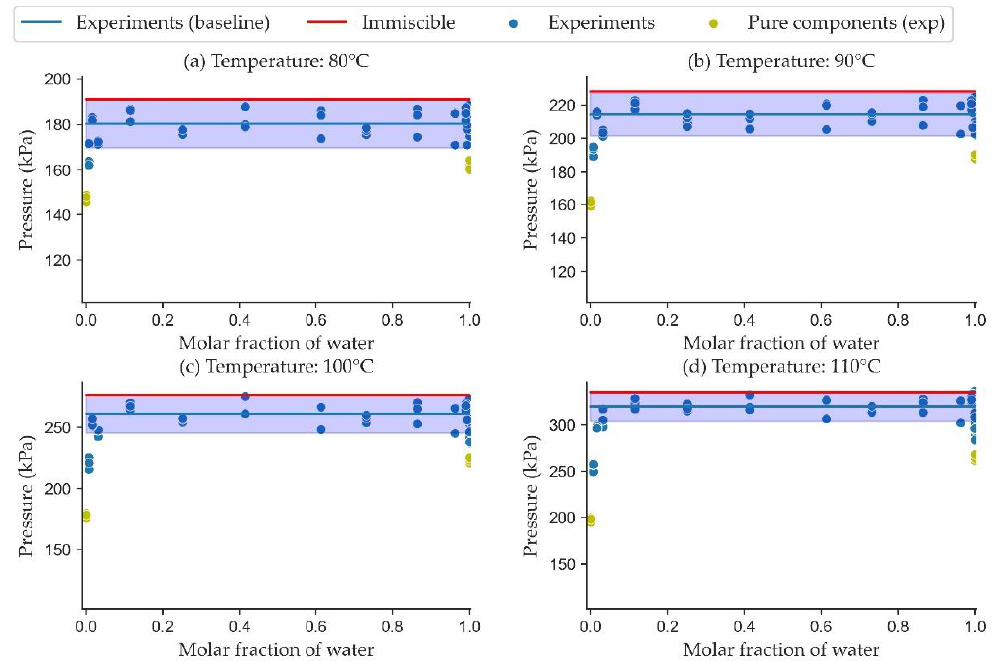
Figure 9. Schematic Description of the Two and Three Phase Regions for n-Octane/Water Blends Using the NRTL Model.